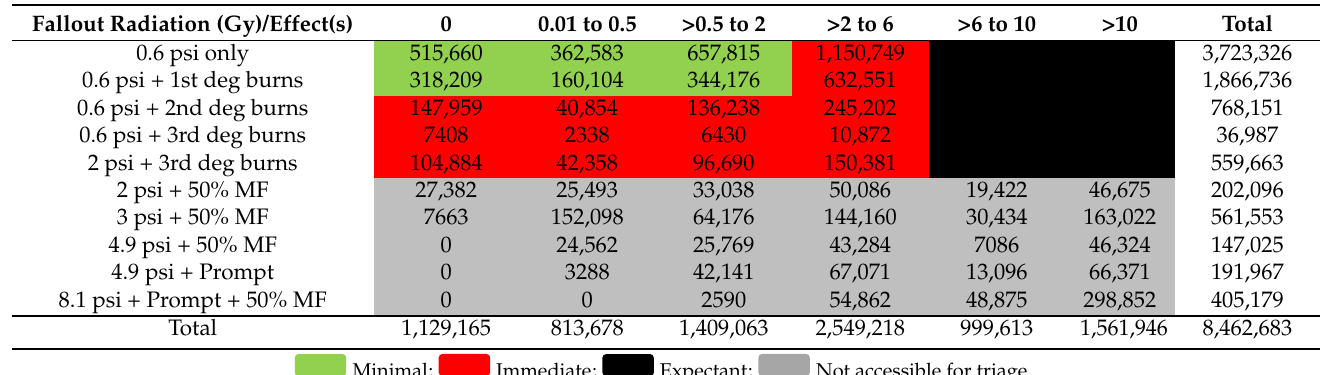
Table 6. Human casualties due to combined injuries (6 × 25 kt nuclear weapons).